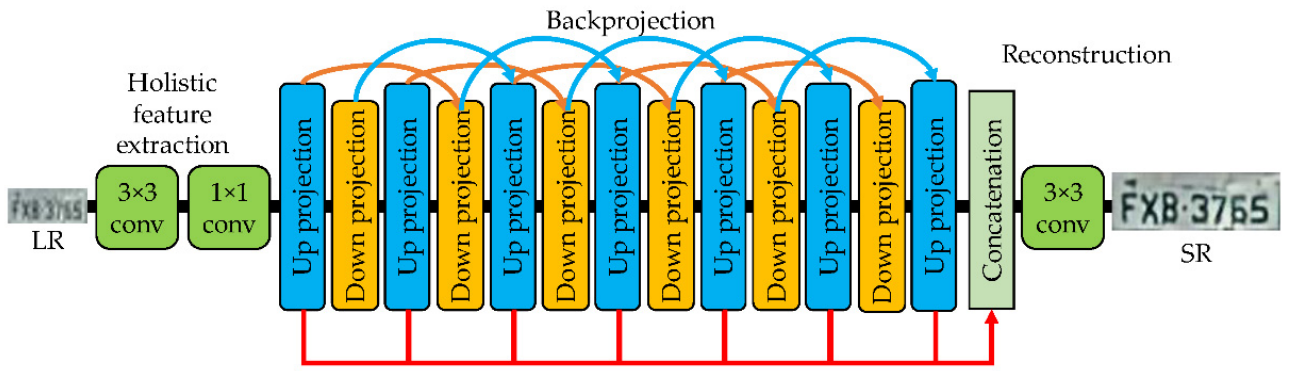
Figure 2. Architecture of holistic-feature-extraction-based SR module.